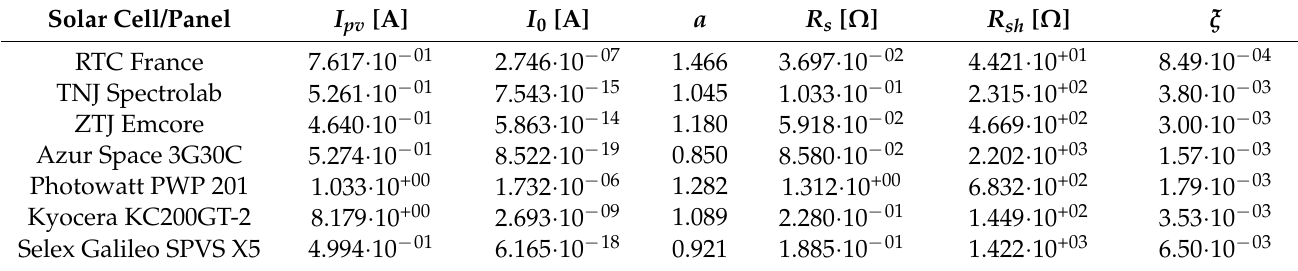
Table 2. Parameters for the 1-D/2-E equivalent circuit models, numerically fitted to I-V curves based on data from RTC France, TNJ Spectrolab, ZTJ Emcore, and Azrur Space 3G30C solar cells, and Photowatt PWP 201, Kyocera KC200GT-2, and Selex Galileo SPVS X5 solar panels (where ξ is the non-dimensional RMSE for the fit). Solar